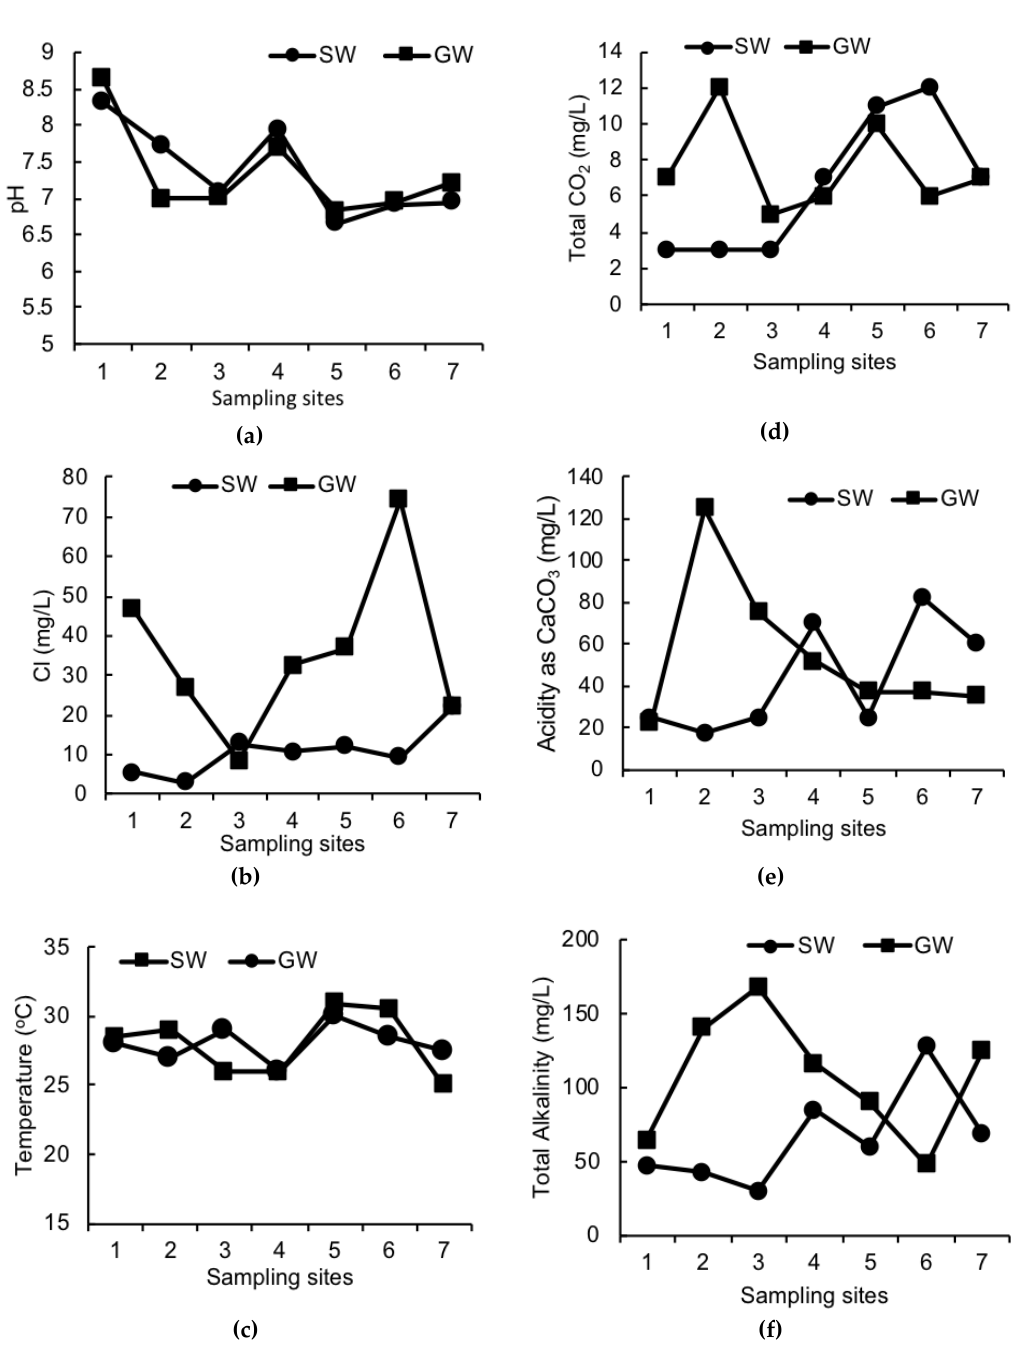
Figure 2. The pH ( a ), chloride concentration ( b ), temperature ( c ), total CO 2 ( d ), acidity ( e ) and total alkalinity ( f ), of the samples from the various sampling sites.